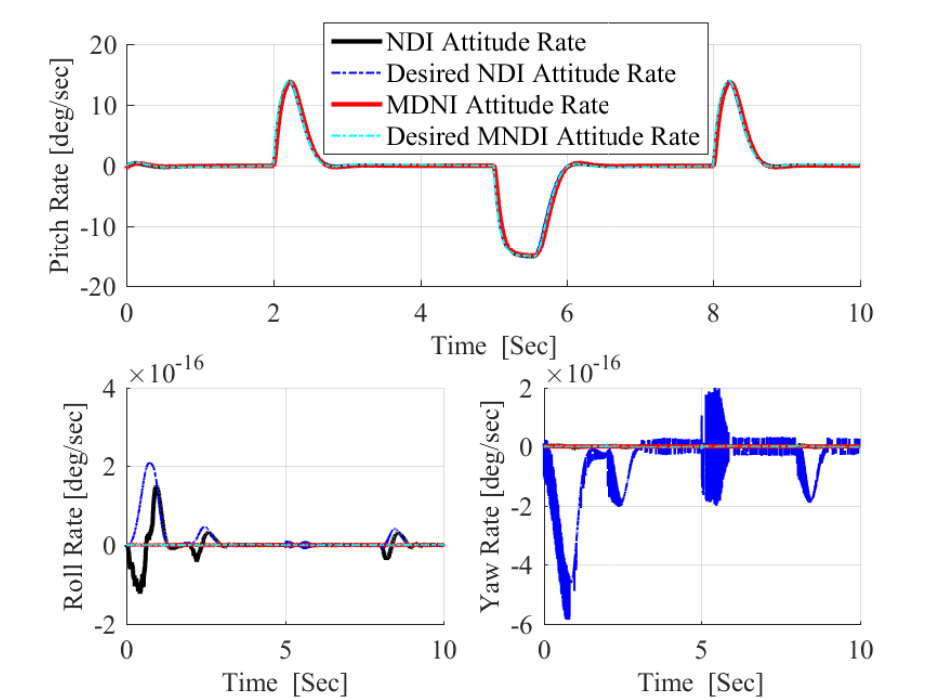
Figure 9. Inner loop rate response for outer pitch angle excitation with